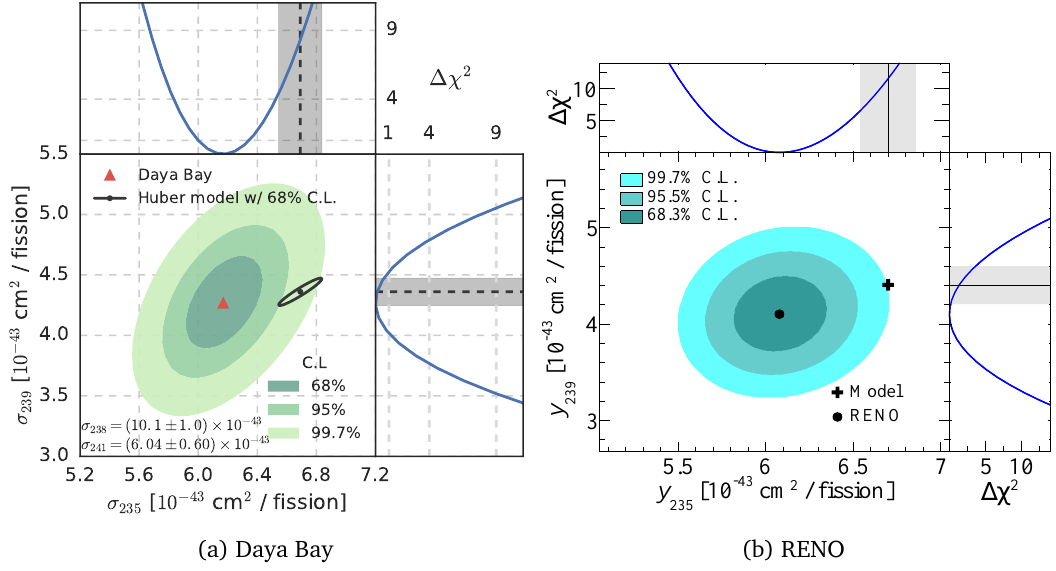
Figure 8: Observed flux yields for 239 Pu, in the vertical axis, and 235 U, in the hor- izontal axis. Theoretical expectations are shown in black (left) and with a cross (right). The 239 Pu measurement agrees with the theoretical expectations, whereas 235 U shows a deficit. Figures extracted from Refs. [ 24,25 ]